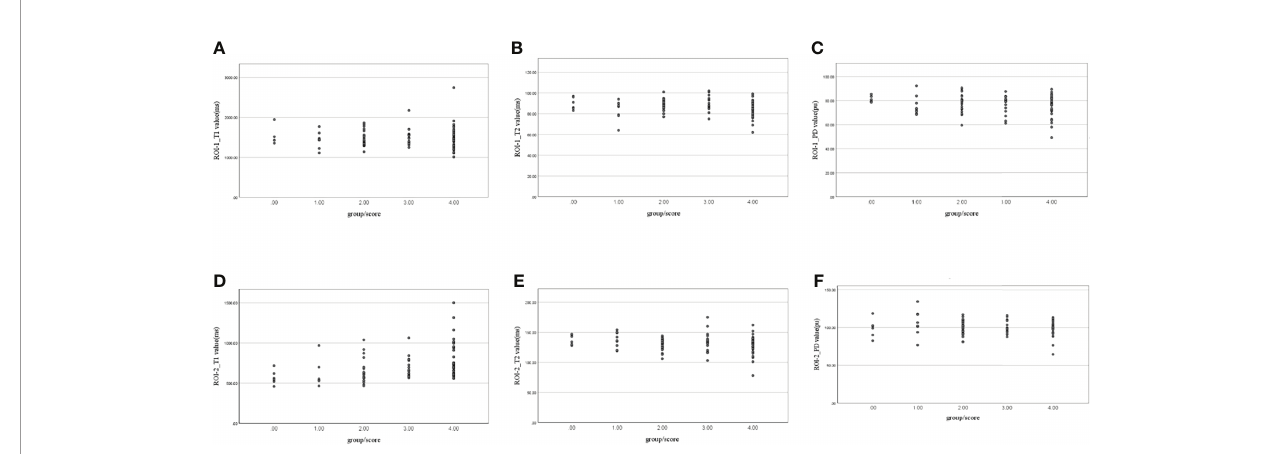
FIGURE 7 | Scatter plots of the correlation between (A) ROI-1_T1, (B) ROI-1_T2, (C) ROI-1_PD, (D) ROI-2_T1, (E) ROI-2_T2, and (F) ROI-2_PD values and extramural venous invasion